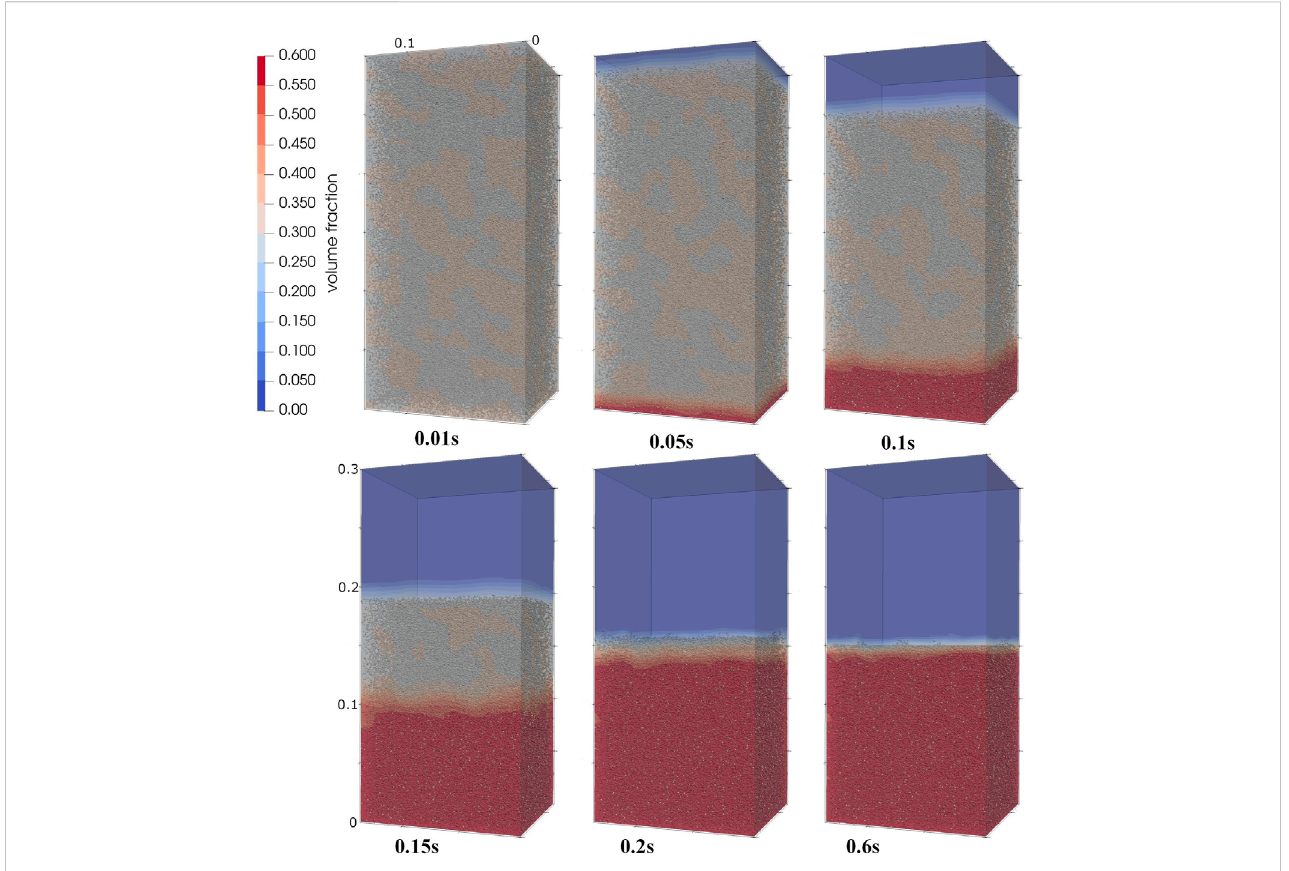
FIGURE 2 Contours of solid phase volume fractions with time during the process of